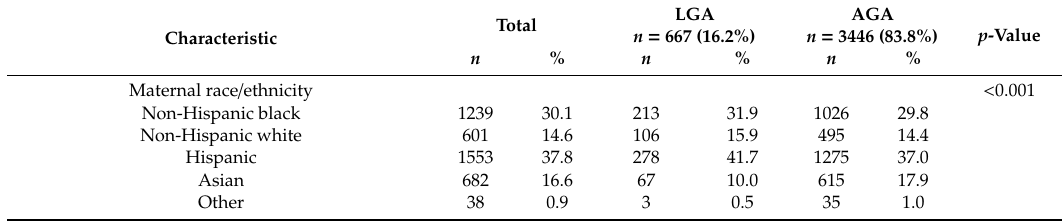
LGA Total n = 667